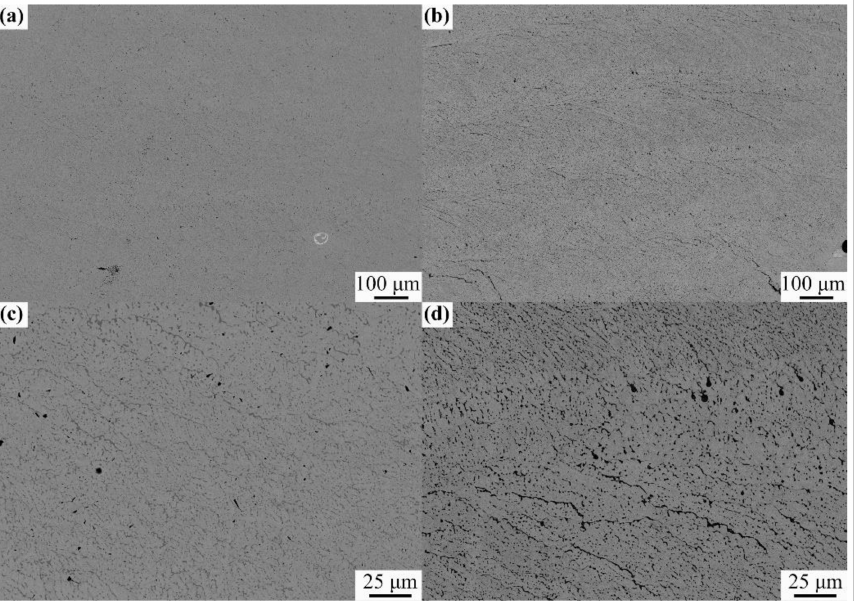
Figure 4. An scanning electron microscope (SEM) image of the composite structure. ( a , b ) multiple units at low magnification; ( c , d ) single unit at high